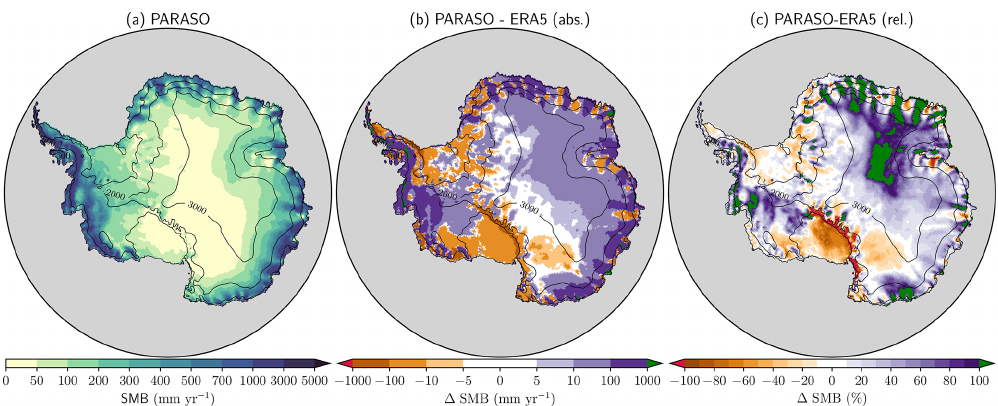
Figure 13. Surface mass balance reconstruction for 2001, the second simulated year. (a) PARASO; (b) PARASO absolute difference w.r.t. ERA5; (c) PARASO relative difference w.r.t. ERA5. Note the nonlinear color scales. Contours denote elevation at 500, 2000 and 3000m above mean sea